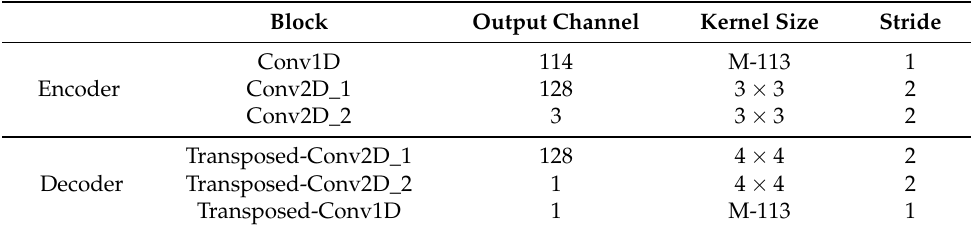
Table 2. Structure 1: Removing one 2D-convolutional layer of the encoder.